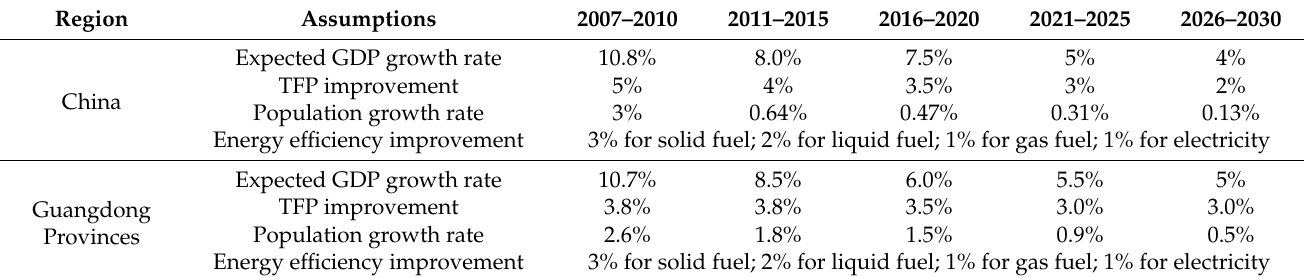
Table 3. Common socio-economic assumptions shared by all scenarios for Guangdong and China.